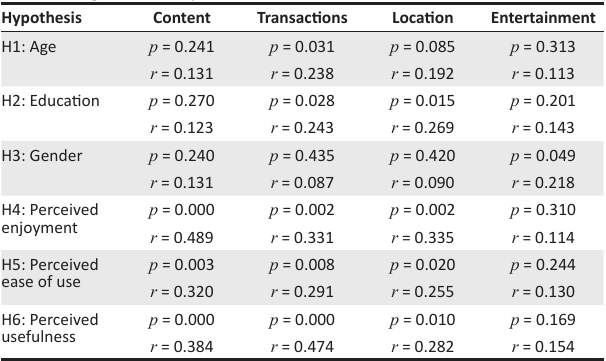
TABLE 4: Regression analysis.